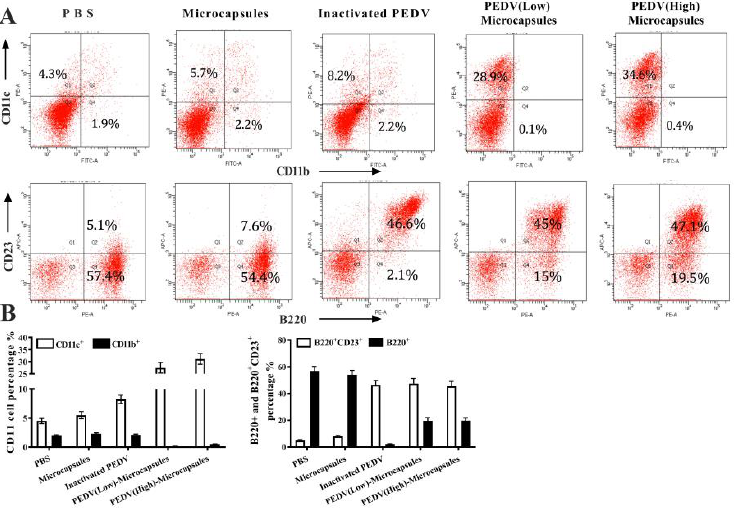
Figure 4. The flow cytometric analysis results for the percentage of CD11b+ and CD11c+ cell for immunization ( A ). ( B ) indicates the percentage of B220+ and CD23+ cell with the flowcytometric